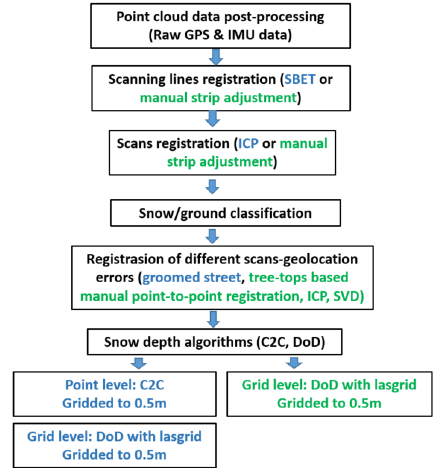
Figure 5 . Schematic workflow of all the processing steps followed until the extraction of the snow depths maps. In blue the algorithms for the flat forest and in green the one for the steep